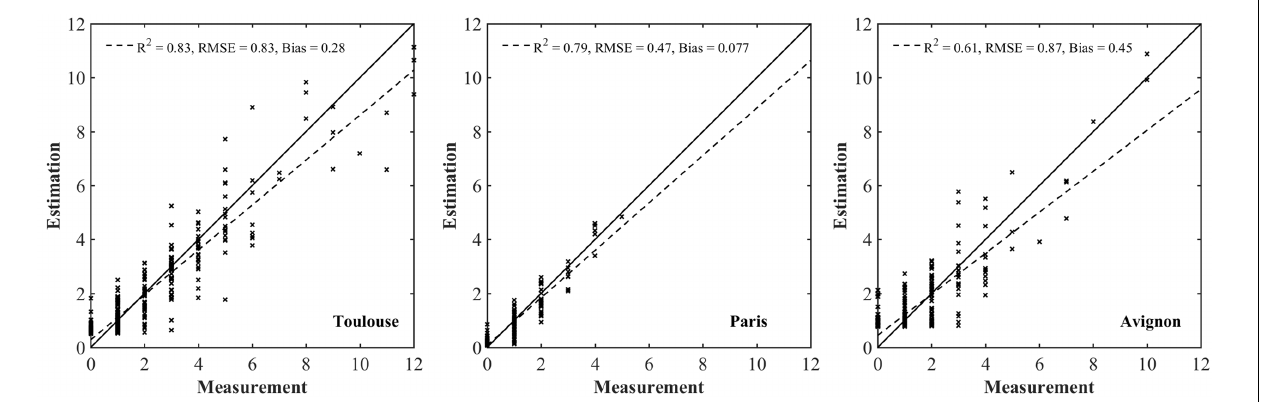
FIGURE 7 | Comparison between the estimated number of plants per object with the value measured over the test dataset for each individual site.